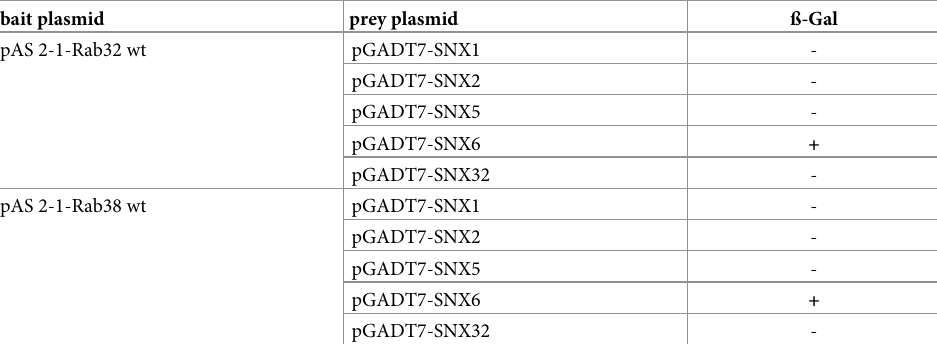
Table 2. Sorting nexin binding specificity for Rab32 and Rab38. bait plasmid prey